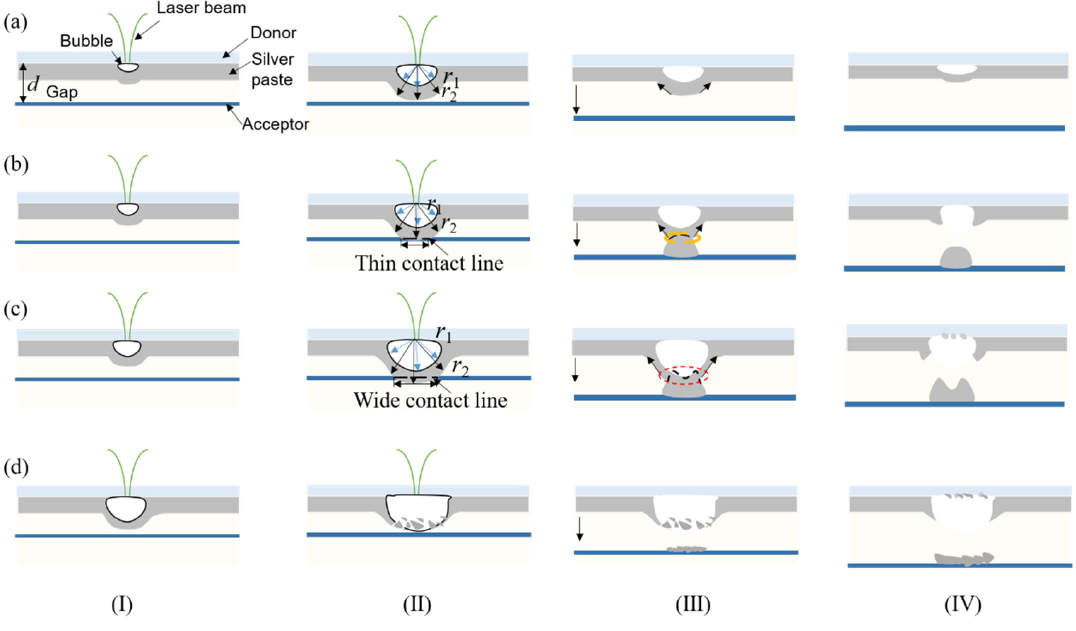
Figure 7. Schematic diagram of dynamic processes for the silver paste transfer under different laser fluences. ( a ) below critical threshold, ( b ) critical transfer threshold, ( c ) above critical threshold, ( d ) much higher than critical threshold.